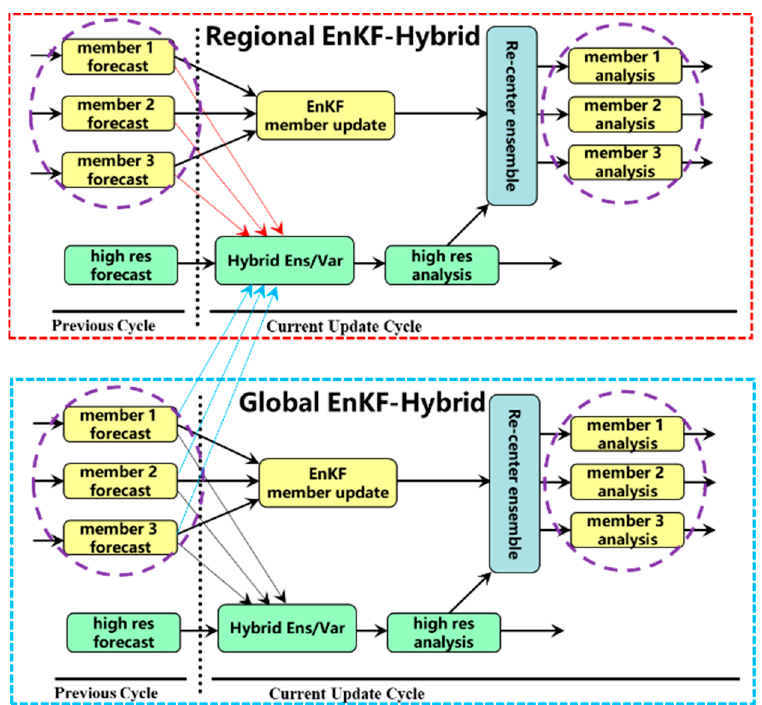
Figure 1. A schematic diagram of the regional hybrid data assimilation using global-ensemble-model-augmented error covariance.